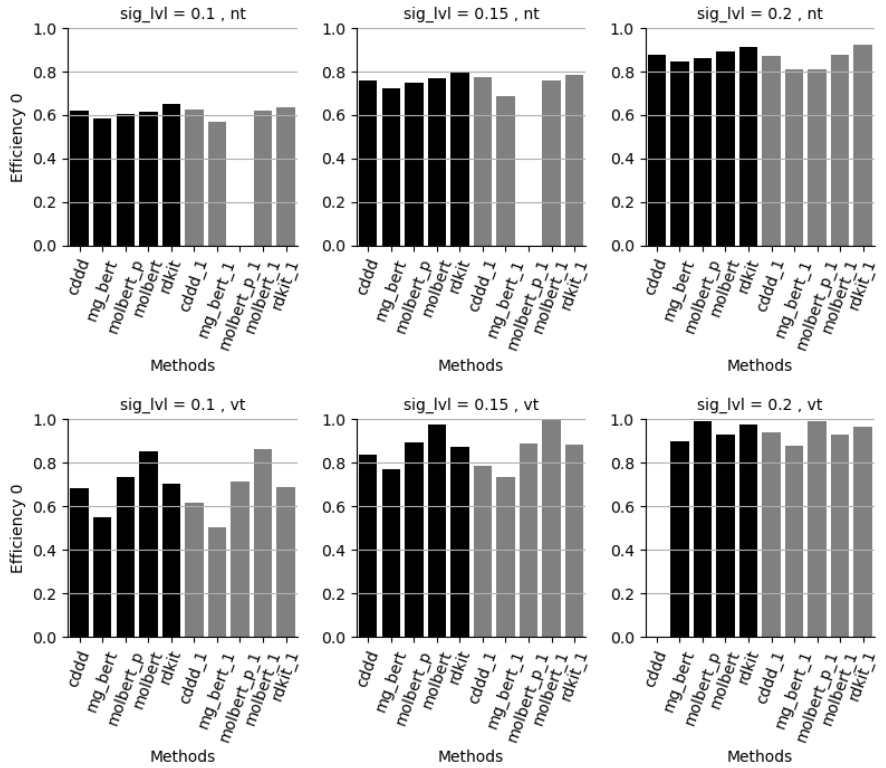
Figure 5. Evaluation set efficiency for class “0” for the 2 datasets (NT model upper row, VT model lower row), at significance levels 0.1–0.2, for each method. Class “0”: the other binary class for each dataset as compared to Figure 4. Methods: cddd = RF/cddd 10 models, mg_bert = Molecular-graph-BERT/smiles 10 models, molbert = MolBERT/smiles 10 models, molbert_p = MolBERT/smiles 10 models with PubChem pre-trained model, rdkit = RF/rdkit 10 models, xxx_1 is the corresponding approach based on only 1 model.